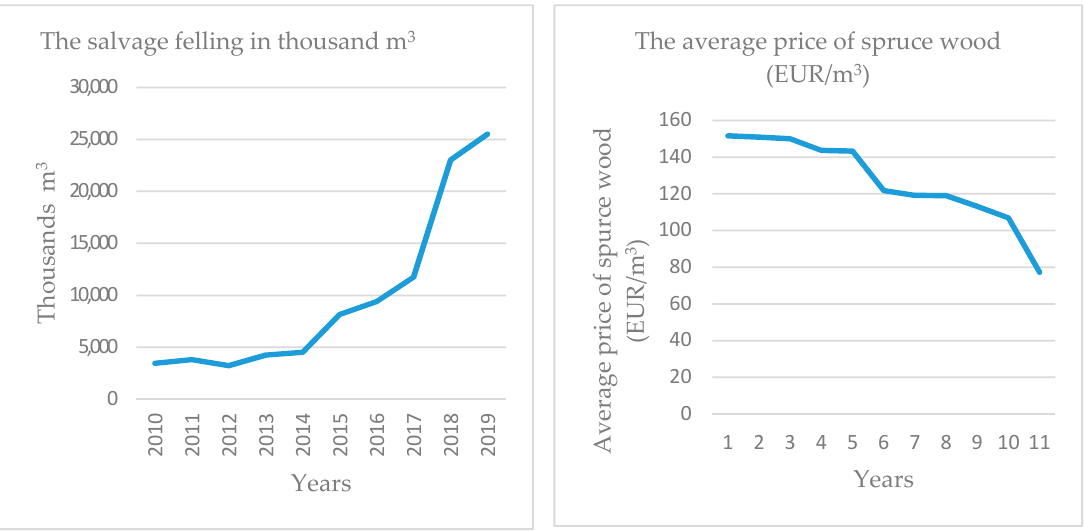
Figure 1. The calamity logging and price of spruce wood; Source: ˇCSU (Czech Statistical Agency), 2019. Table 2. Summary results of linear regression